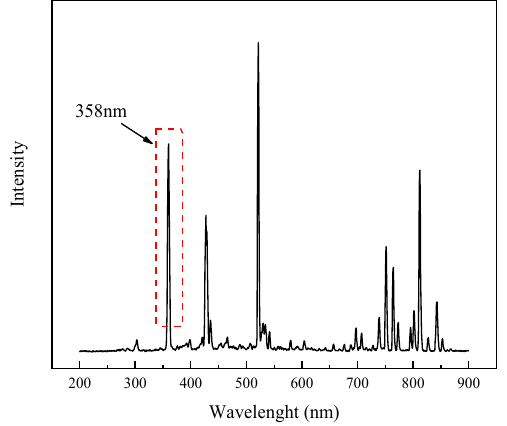
Figure 2. Typical optical emission spectrometer (OES) spectra during sputtering Cr target powered by pulsed-dc (direct current) magnetron sputtering.